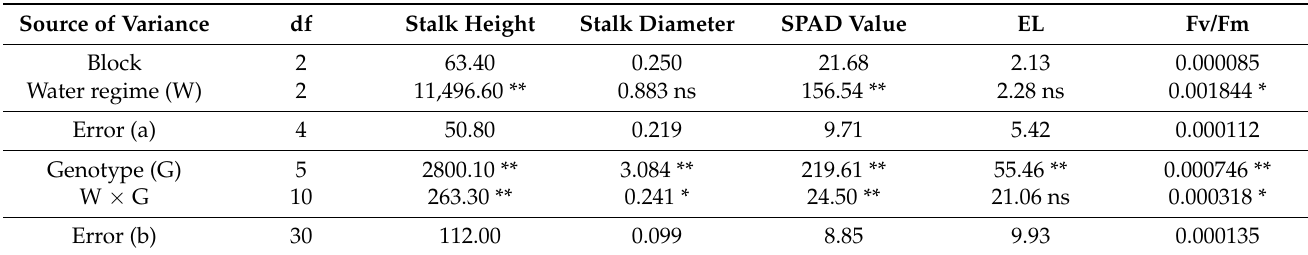
Table 1. Mean squares for stalk height and diameter, Soil Plant Analysis Development (SPAD) value, electrolyte leakage (EL) and maximum quantum yield of PSII efficiency (Fv/Fm) of six sugarcane genotypes under early drought conditions (determined four months after planting).